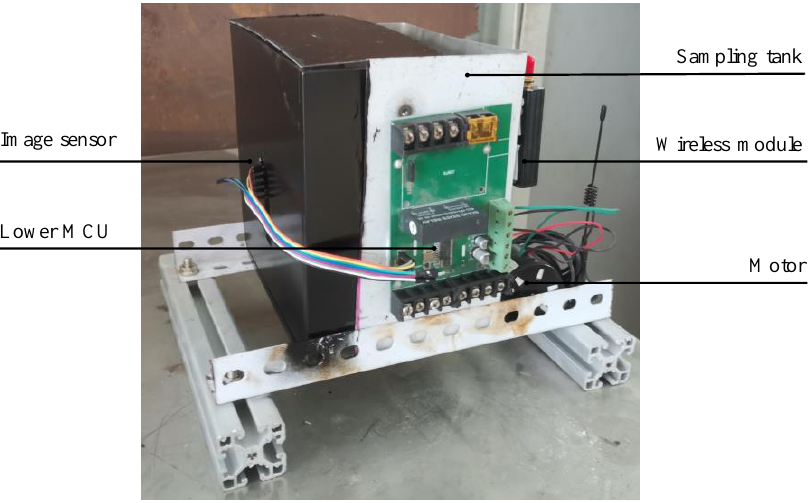
Figure 11. Prototype of online impurities detection device in the corn deep-bed drying process.